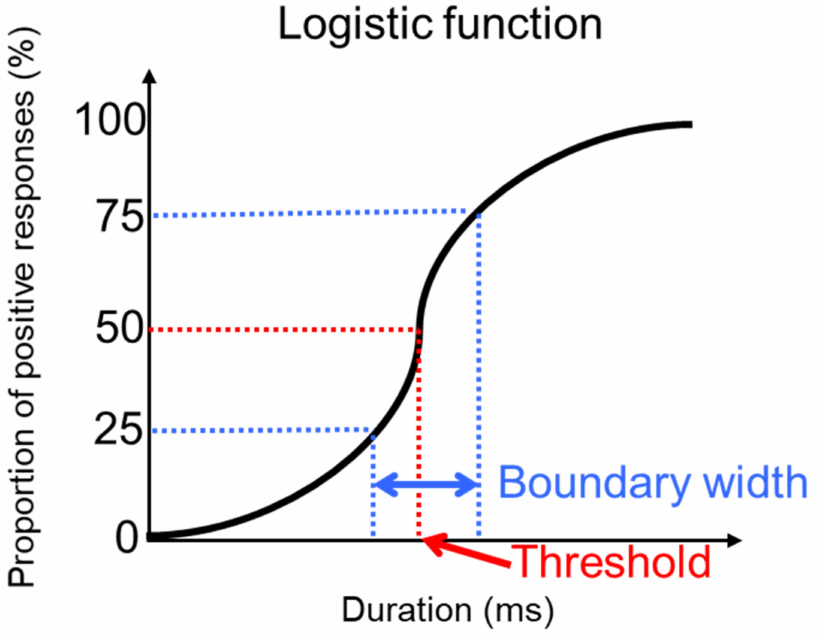
Figure 2. Evaluation of the categorization boundary using a logistic